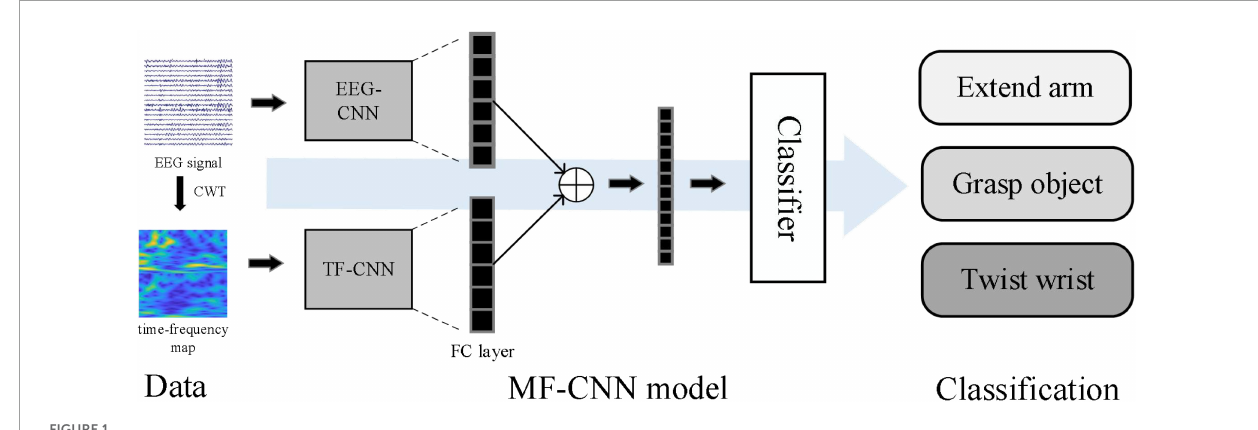
FIGURE1 Workflow of the proposed